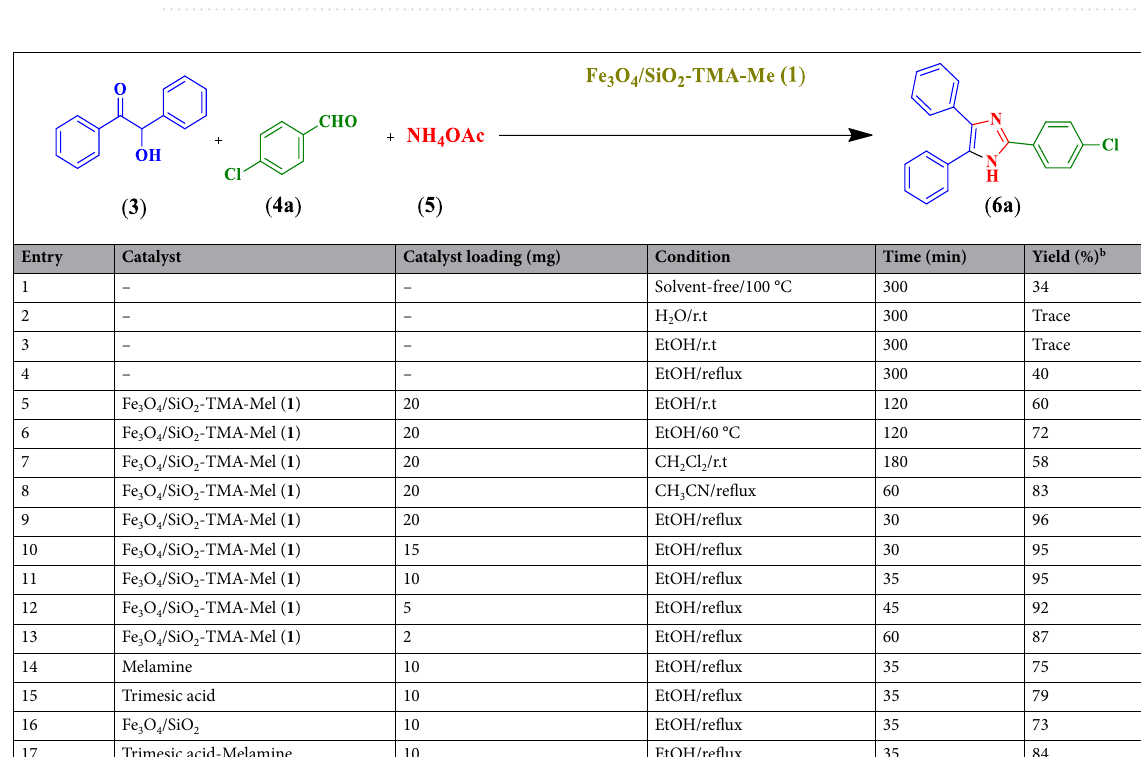
Figure 8. TGA/DTA curves of the Fe 3 O 4 /SiO 2 -TMA-Me, nanocomposite ( 1 ).